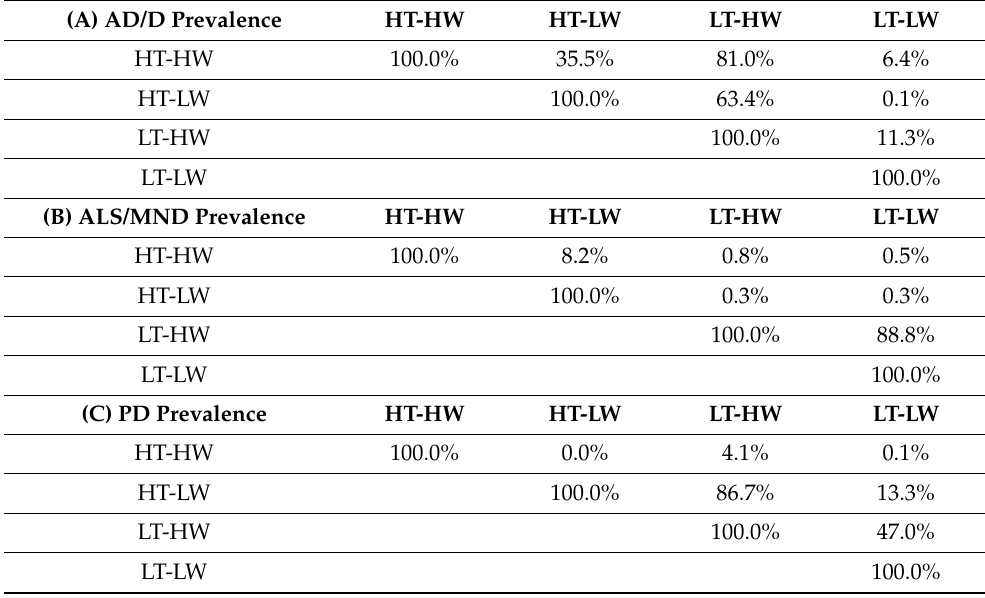
Table 2. Differences between the distributions of prevalence indices for the 4 clusters for ( A ) AD/D, ( B ) ALS/MND and ( C ) PD patients. The Table reports the p -value of the Student’s t -test calculated between the distributions of prevalence for the different clusters. Bold values identify the statistically significant correlations with Student’s t -test p < 0.05 (5%). For example, in ( A ) the fact that p = 35.5% for the distributions of the HT-HW and the HT-LW clusters, indicates that there is a 35.5% chance that the two distributions come from a different overall